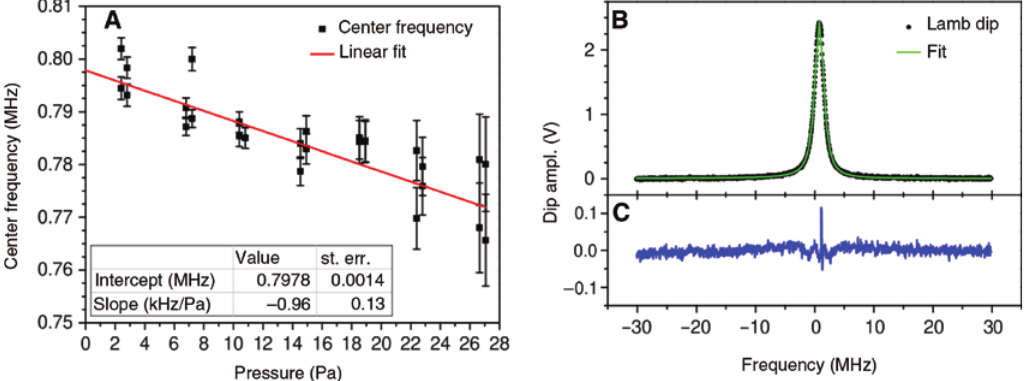
. Figure 9: High-resolution spectroscopy on CO 2 (A) Dependence of the center of the Lamb dip of the CO (01 1 1 − 01 1 0) P(29)e transition on pressure, with the corresponding linear fit. For 2 clarity, the constant value of 69297478 MHz has been subtracted from the absolute frequency values. (B) Example of a single Lamb dip acquisition. Experimental conditions: lock-in amplifier time constant of 10 ms, chopper frequency of 616 Hz, frequency scan with 60-MHz span and 50-kHz steps. The fit to a Voigt function (green line) and the residuals (C) are also plotted. Adapted from [47].